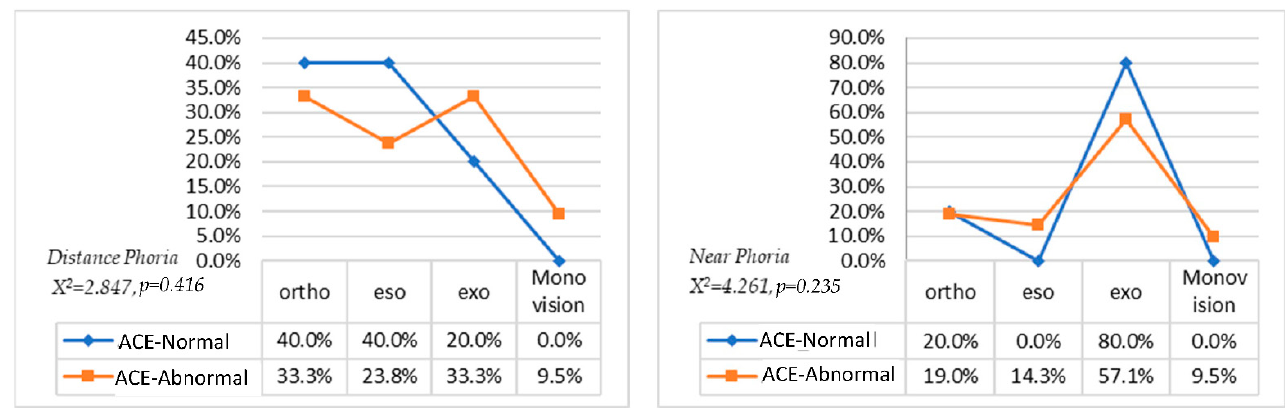
6 of 11 Figure 2. ADEM types between ACE-normal and -abnormal subjects. 3.2.2. ACE Cognitive Function and Phoria Distant phoria test showed: in the ACE-abnormal group, there were seven patients with orthophoria, five with esophoria, seven with exophoria, and two with monovision;